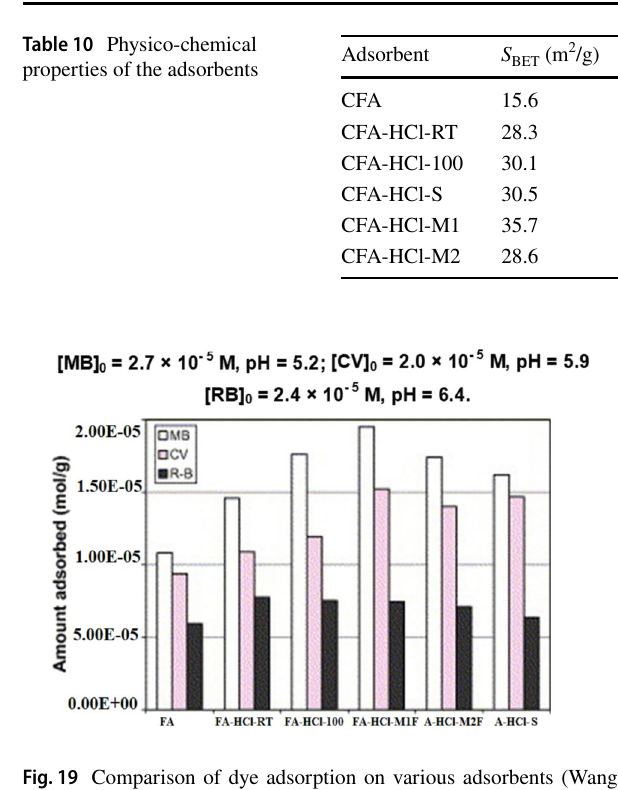
Fig. 19 Comparison of dye adsorption on various adsorbents (Wang et al. 2005a, b)